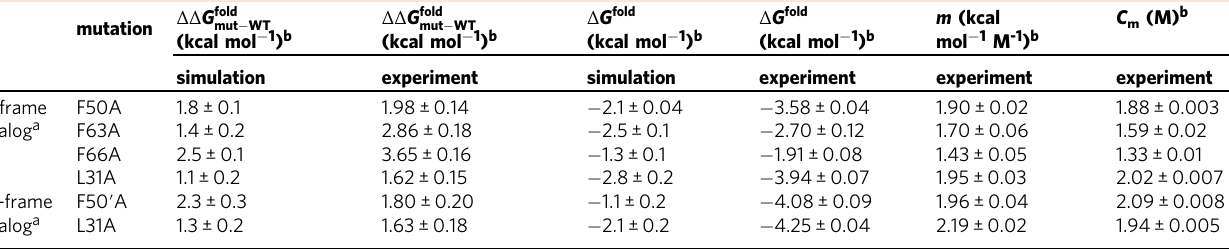
a N-frameandN ′ -frameanalogsrepresentWTandCPcalbindin,respectively,withE65Qmutations.Inexperiment,theN-frameanalogincludesaninsertedcysteineresidueatposition44.Thestabilities of the N-frame analog ( Δ G fold = − 5.56±0.13kcalmol − 1 , m = 1.88±0.05kcalmol − 1 M − 1 , C m = 2.95±0.01M) and N ′ -frame analog ( Δ G fold = − 5.88±0.18kcalmol − 1 , m = 2.13±0.05kcalmol − 1 M − 1 , C m = 2.76±0.01M) are similar to WT and CP calbindin (Supplementary Table 1). b Values indicate mean±s.e.m. (calculated by propagation of error for ΔΔ G fold of folding and three independent WE simulations of unfolding for values from simulation; n = 5 equilibrium denaturation experiments for mutant analogs; n = 7 equilibrium denaturation experiments (including the two reversibility controls shown in Supplementary Fig. 7) for the WT N-frame and N ′ -frame